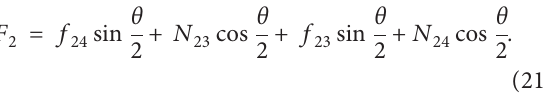
Figure 18: The force analysis of soil particles under axial compression condition. (a) The force analysis of soil particles O analysis of soil particles O 4